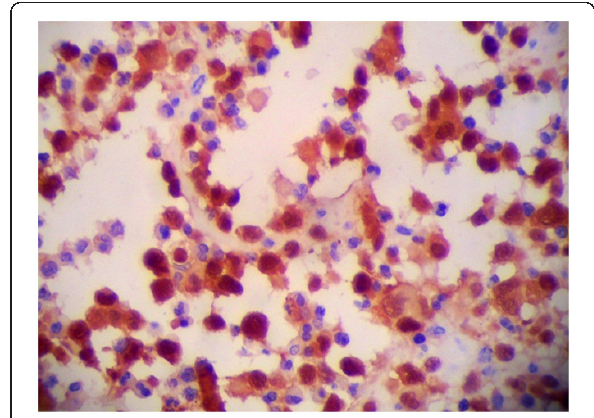
Figure 4 LCS tumor cells expressed S-100 protein (400×).